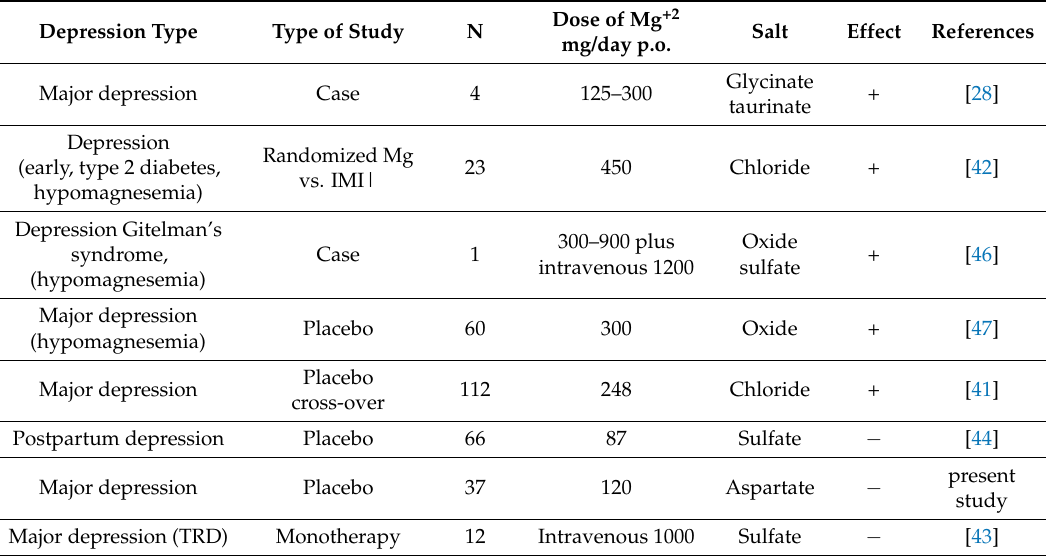
Table 4. Effect of magnesium (Mg) supplementation in human